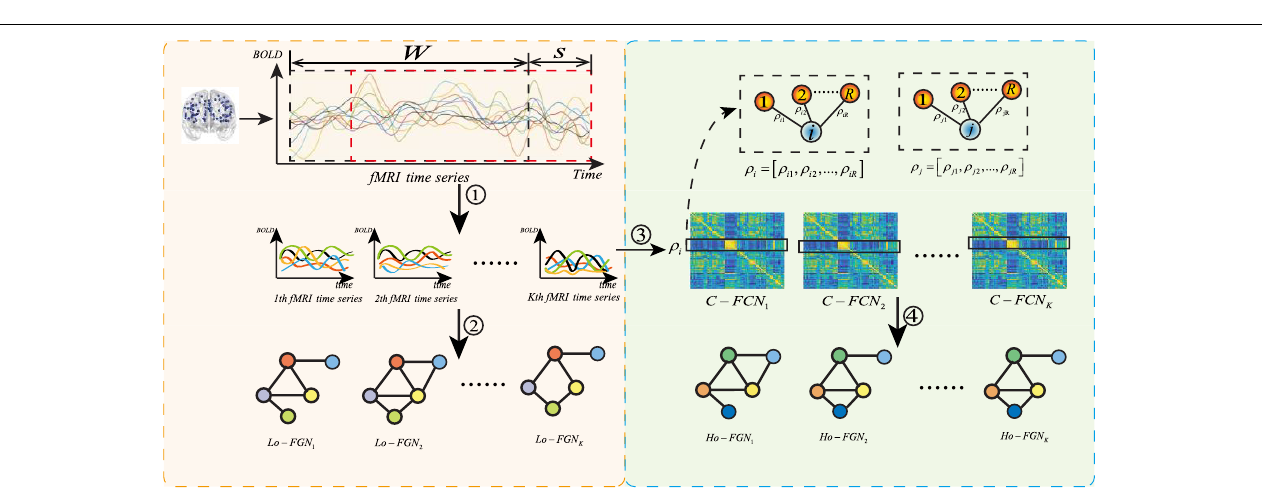
FIGURE 5 | Self-attention graph pooling method diagram, where (A) represents the connectivity among brain regions before the pooling operation, (B) represents the connectivity among brain regions after the pooling operation, and thickness of lines represents the strength of connectivity among brain regions, the fork sign represents that the pooling operation can discard some less important nodes and retain the nodes with more discriminative features.